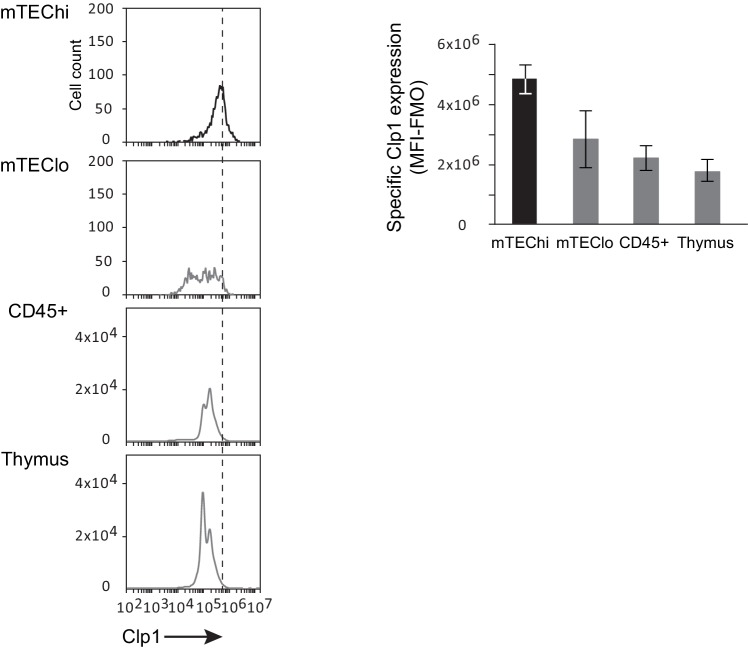
Clp1 expression in the thymus.Clp1 expression is shown as Mean Fluoresence Intensity (MFI) in mTEChi, mTEClo, thymic-sorted CD45+ and the entire thymus (Left) and is subtracted of fluorescence minus one (FMO) control signals from two independent experiments (Right).